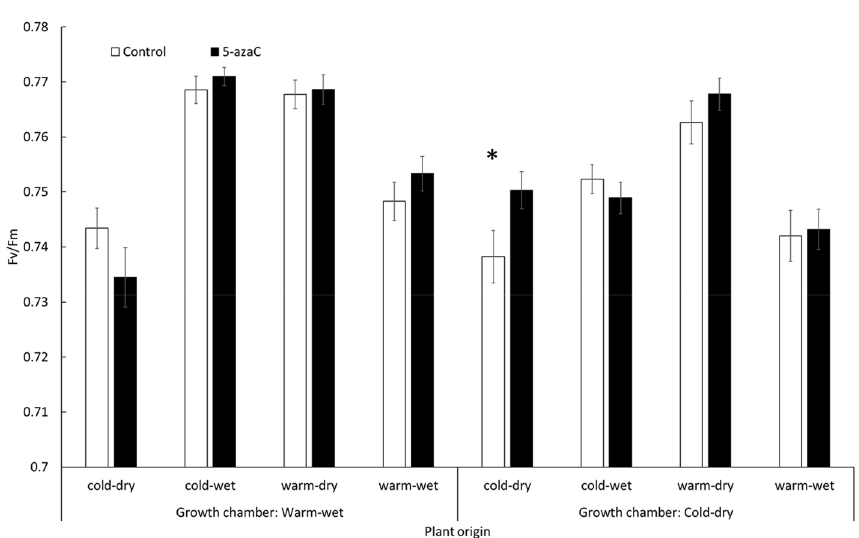
Figure 4. The effect of interaction between original conditions, growth chamber and 5-azaC application on maximum photosystem II (PSII) efficiency (F v /F m ). Columns show mean ± SE. Asterix denotes significant difference within pair of columns (p ≤ 0.05). The data were measured at the end of the experiment using 6 replicates of each of 6 genotypes from each of 4 populations of origin grown in 2 growth chambers, all subjected to control and 5-azaC treatments, resulting in 576 experimental plants. The overall test is reported in Table